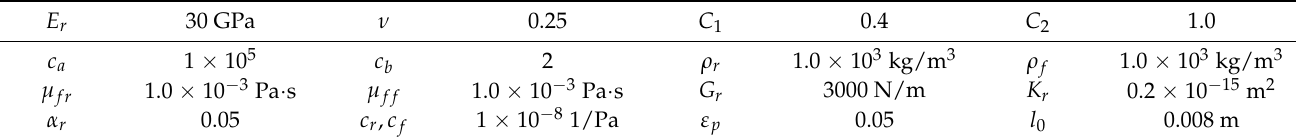
Table 3. The parameters of gravel and weak interface.